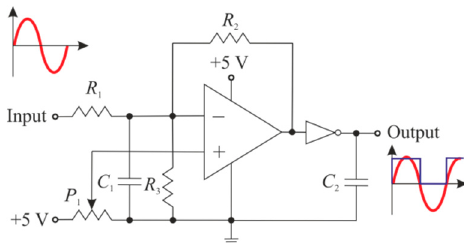
Figure 13. Circuit diagram of the zero-crossing detector.